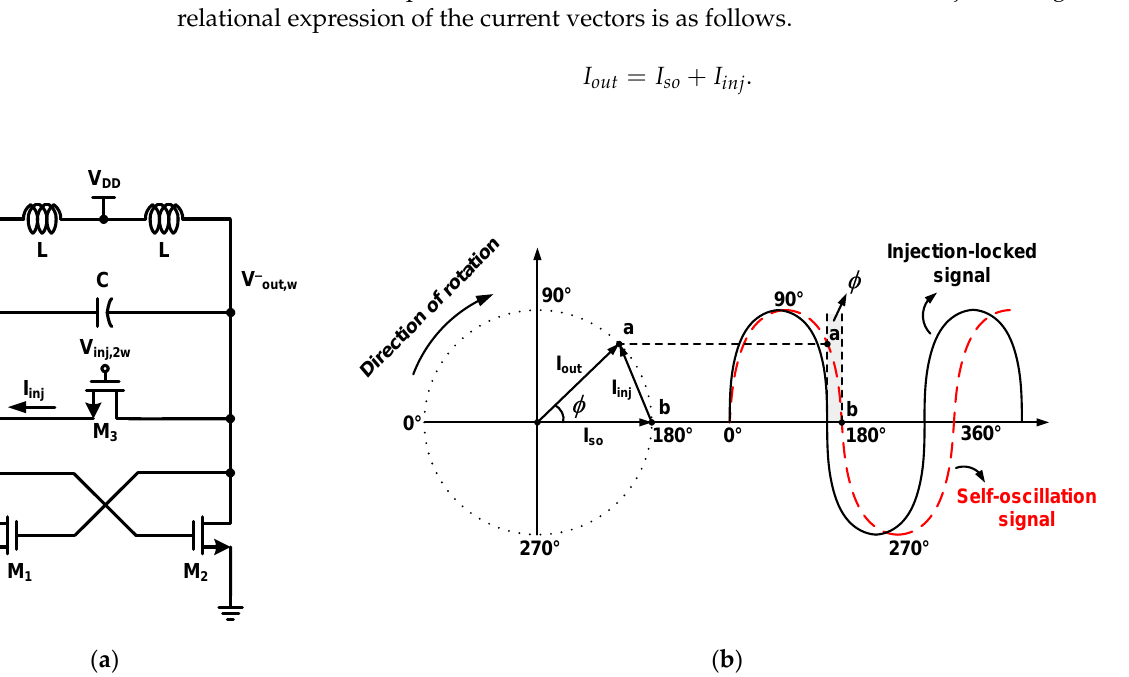
Figure 2. ( a ) Schematic of the conventional cross-coupled pair ILFD with second-order resonator and ( b ) phasor diagram for the basic principle of the conventional ILFD.